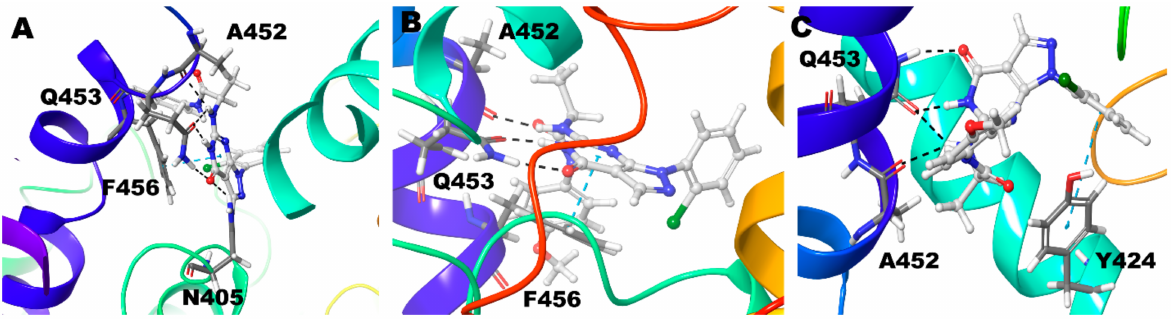
Figure 5. Non-bonded interactions of Compound 2 ( R ) in ( A ) PDE9 Zn/Mg ( B ) PDE9 Mg/Mg ( C ) PDE9 Zn/Zn.